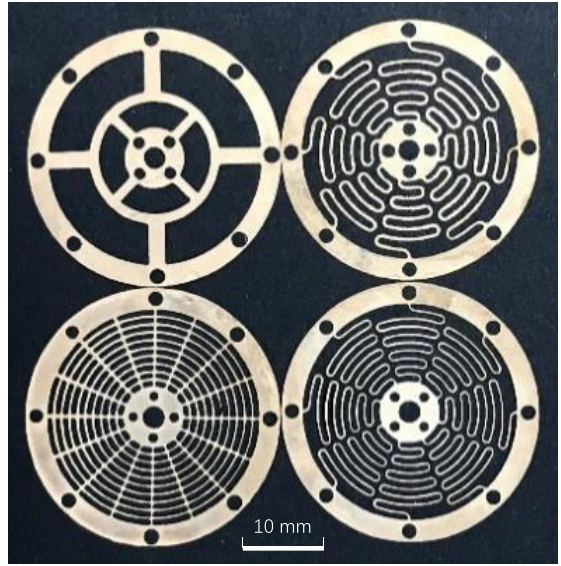
Figure 8. Leaf springs with a complex pattern.